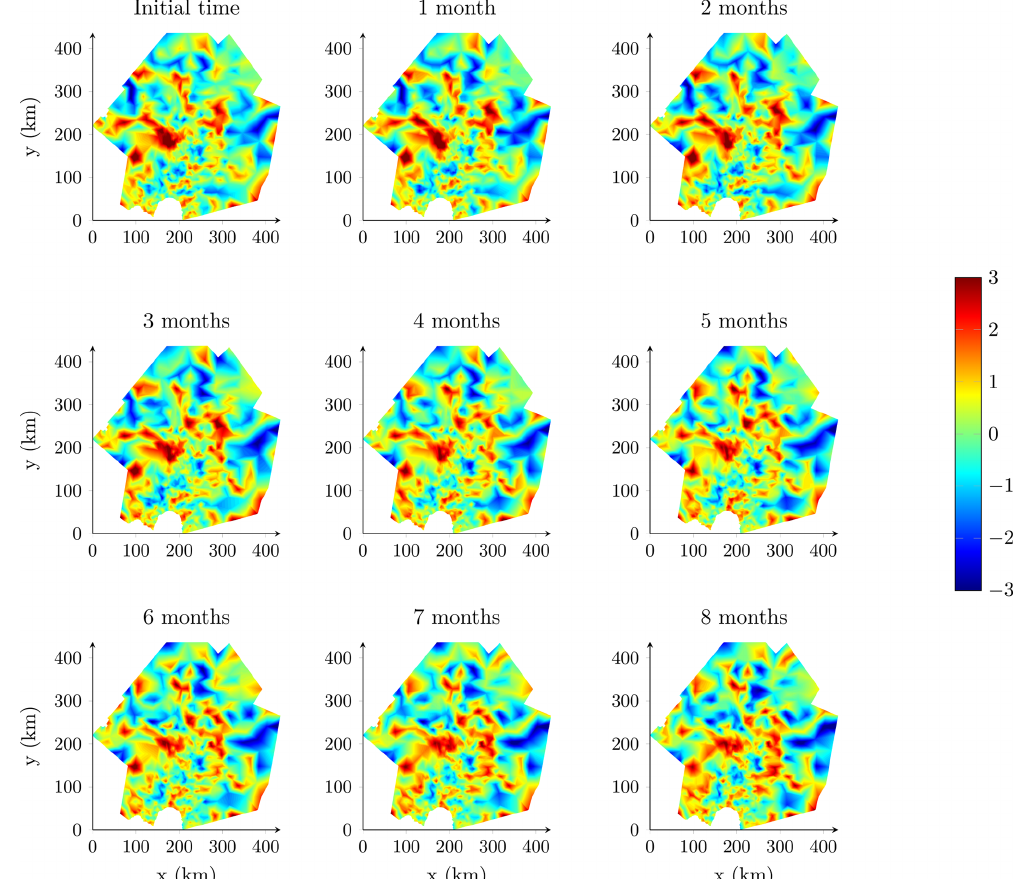
Figure 15. The same as Fig. 14 but with a temporal correlation of 0.95. Figures 14 and 15 have the state initial